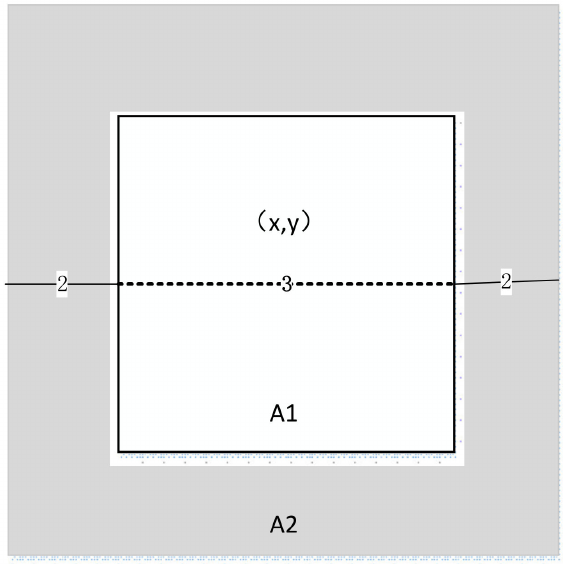
Figure 4. Schematic drawing of gradient